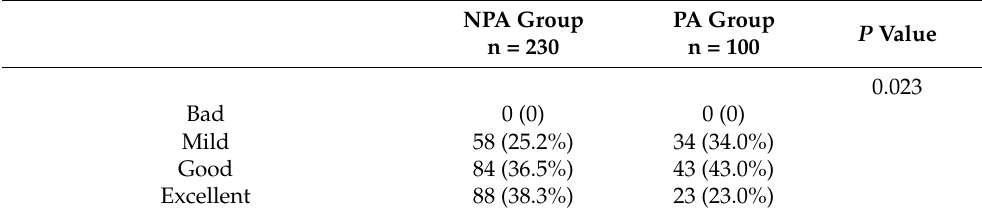
Table 4. Postoperative Patient Satisfaction.